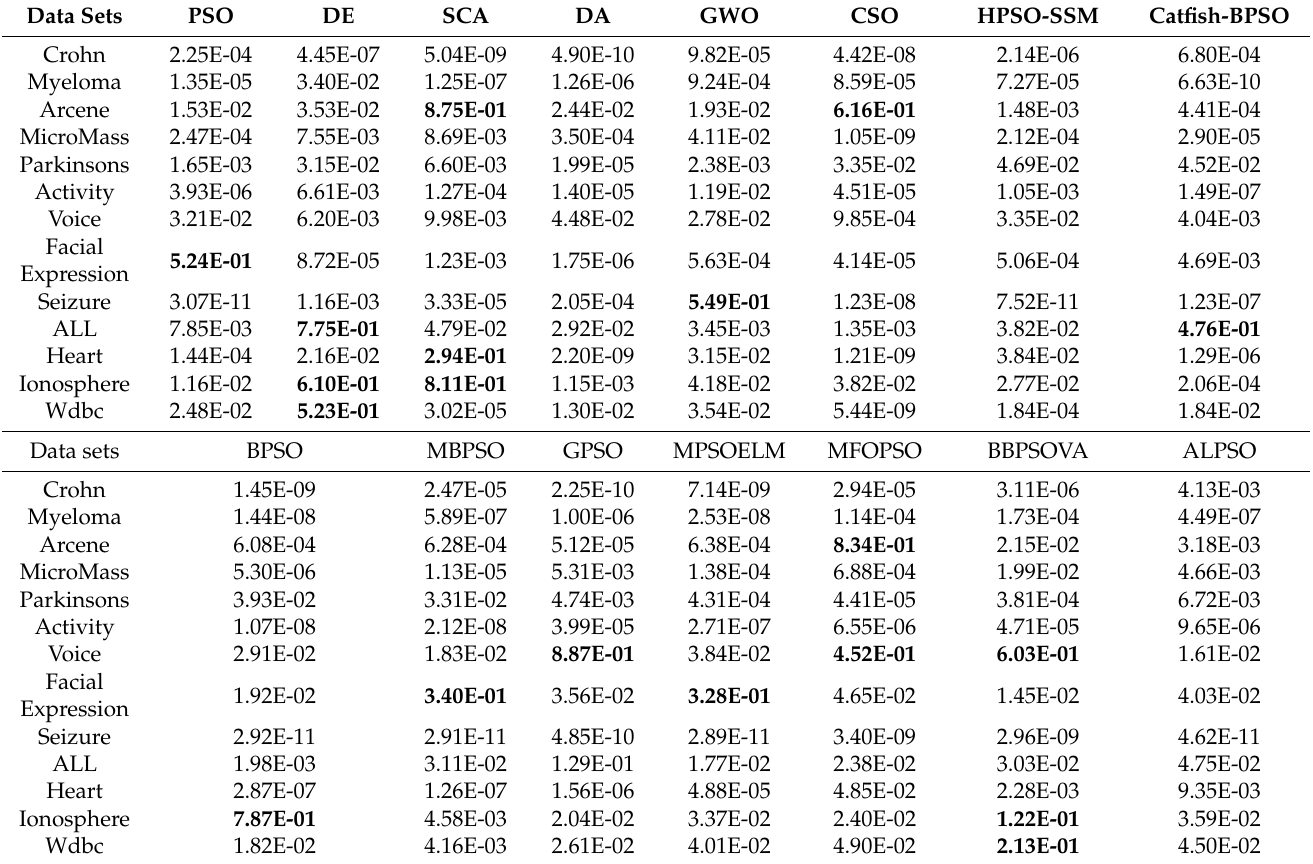
Table 6. The Wilcoxon rank sum test results of the proposed PSOVA1